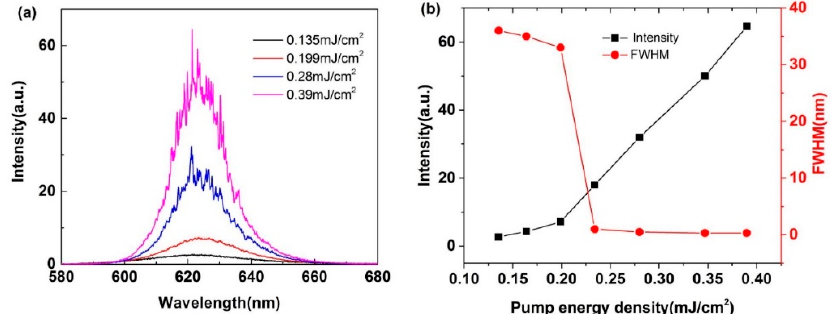
Figure 2. ( a ) Evolution of the emission spectrum of the NPDDNLC sample as a function of the pump energy density. ( b ) The peak intensity and FWHM of the emission spectrum of the NPDDNLC sample as a function of the pump energy density.